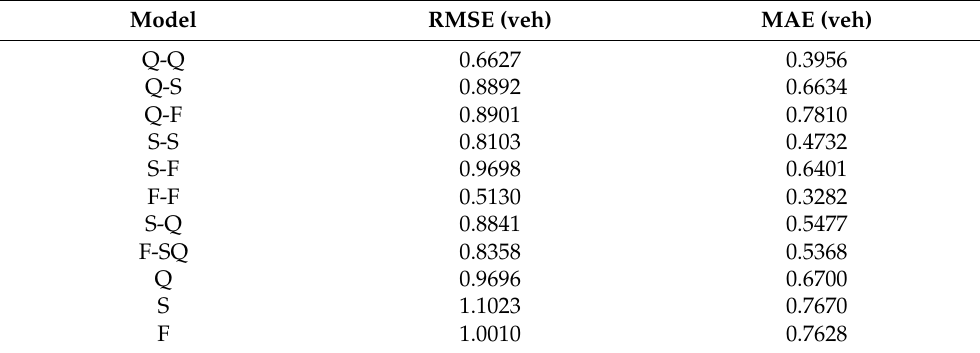
Table 8. Performance measures for the disaggregated estimation methods on real data. Model RMSE (veh) MAE (veh)